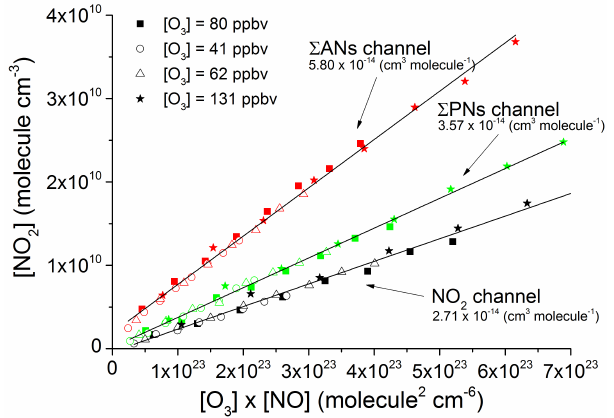
Figure 9. Production of NO 2 from the O 3 + NO reaction when sam- pling into the three 405nm channels with different amounts of NO and O 3 . The numbers in parentheses are the slopes of least-squares fits (solid lines), which correspond to the product of the effective second-order rate constant and the reaction